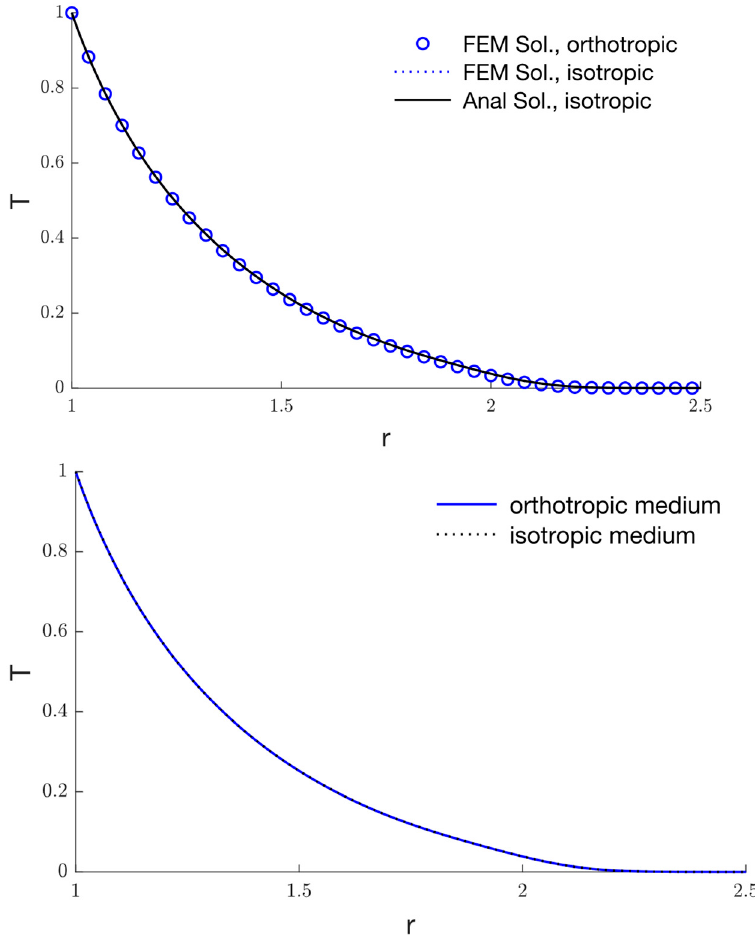
Figure 18. The temperature variation 𝑇 for different materials.